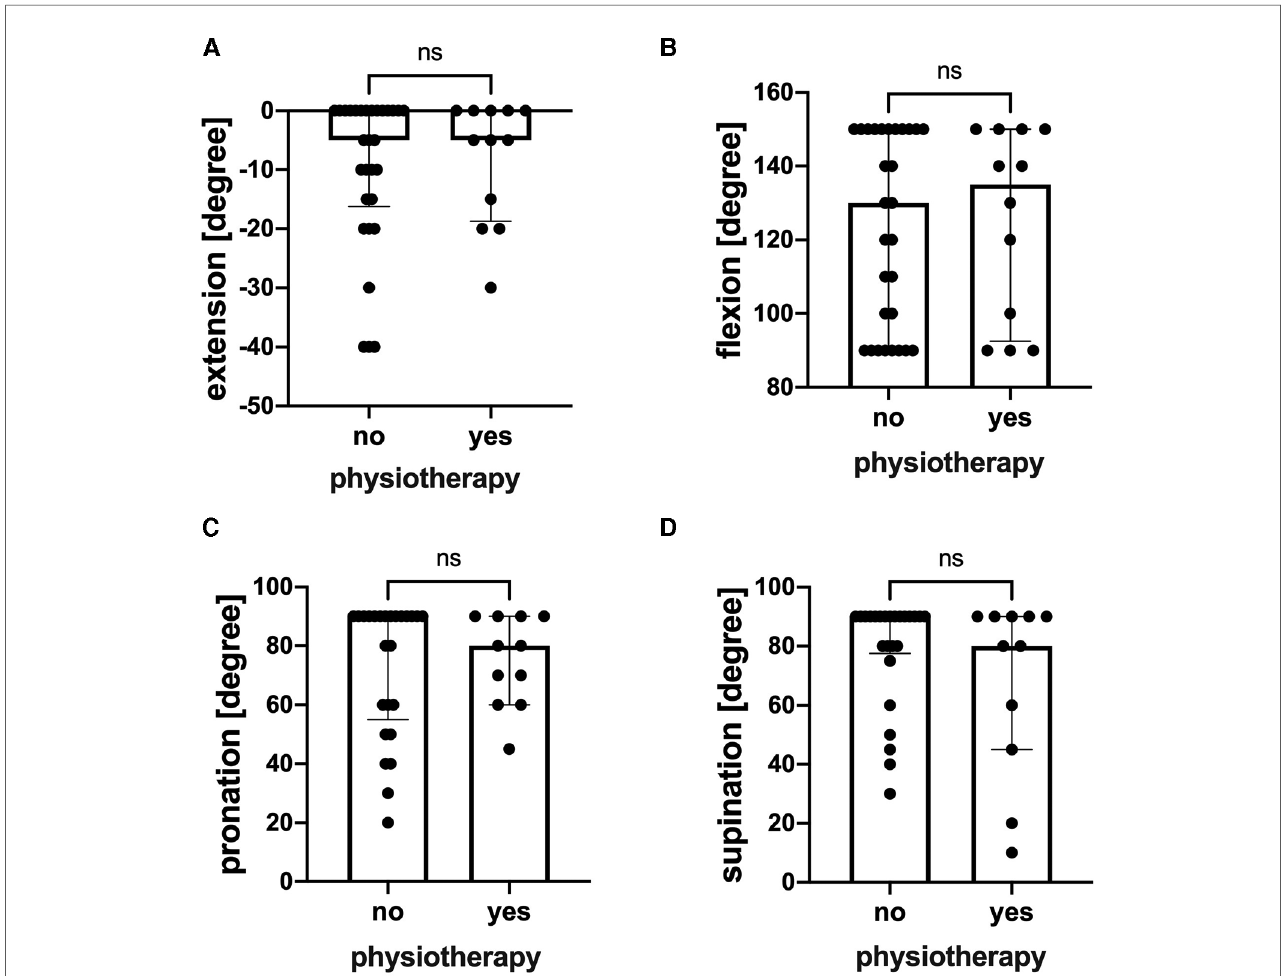
FIGURE 6 Range of motion after fracture consolidation with and without physiotherapy. ( A ) Extension of the elbow (degree), n =30 without physiotherapy, n =12 with physiotherapy. ( B ) Flexion of the elbow (degree), n =30 without physiotherapy, n =12 with physiotherapy. ( C ) Pronation of the elbow (degree), n =26 without physiotherapy, n =12 with physiotherapy. ( D ) Supination of the elbow (degree), n =26 without physiotherapy, n =12 with physiotherapy. Graphical presentation as median with interquartile range. ns=not signi fi cantly